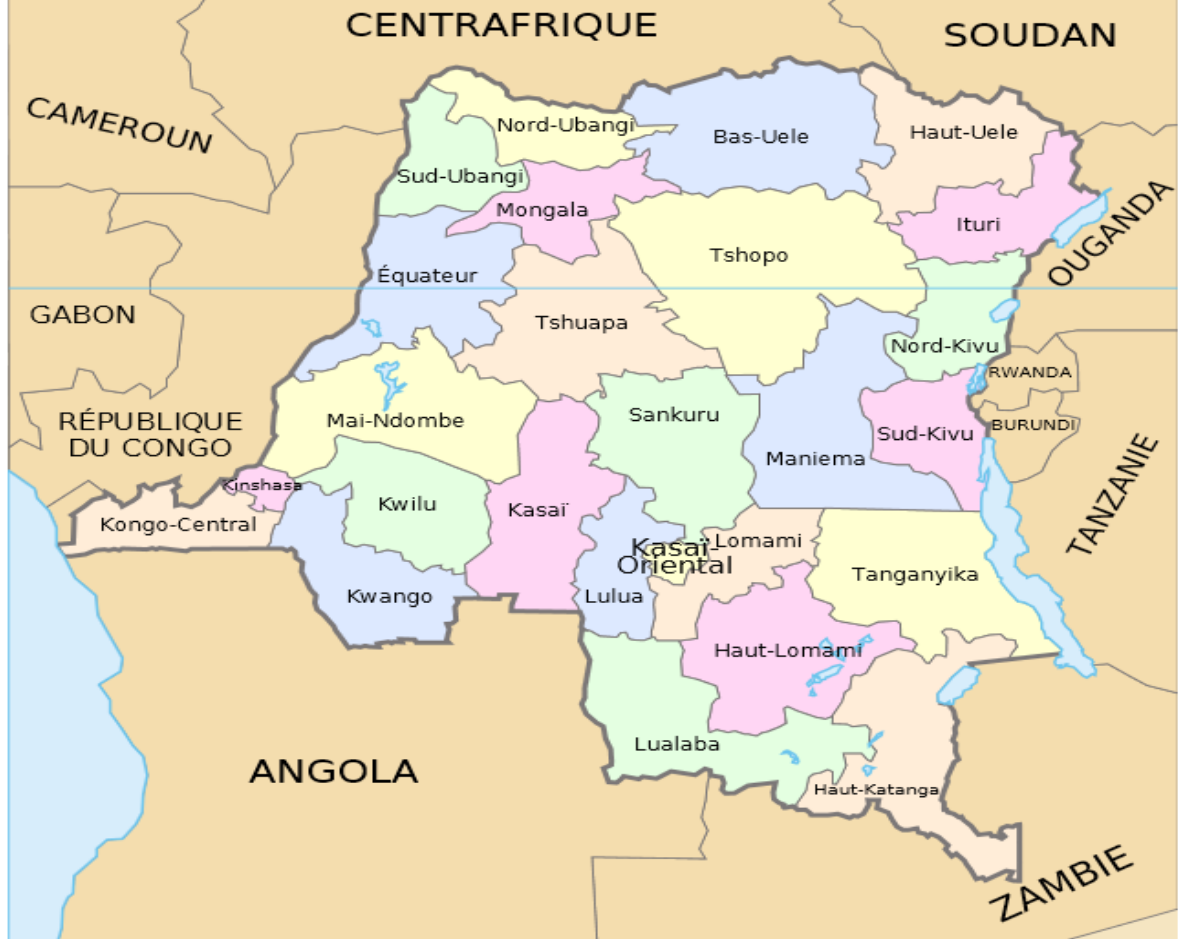
Figure-0A: A map showing the study country and South Province among the 26 Provinces of